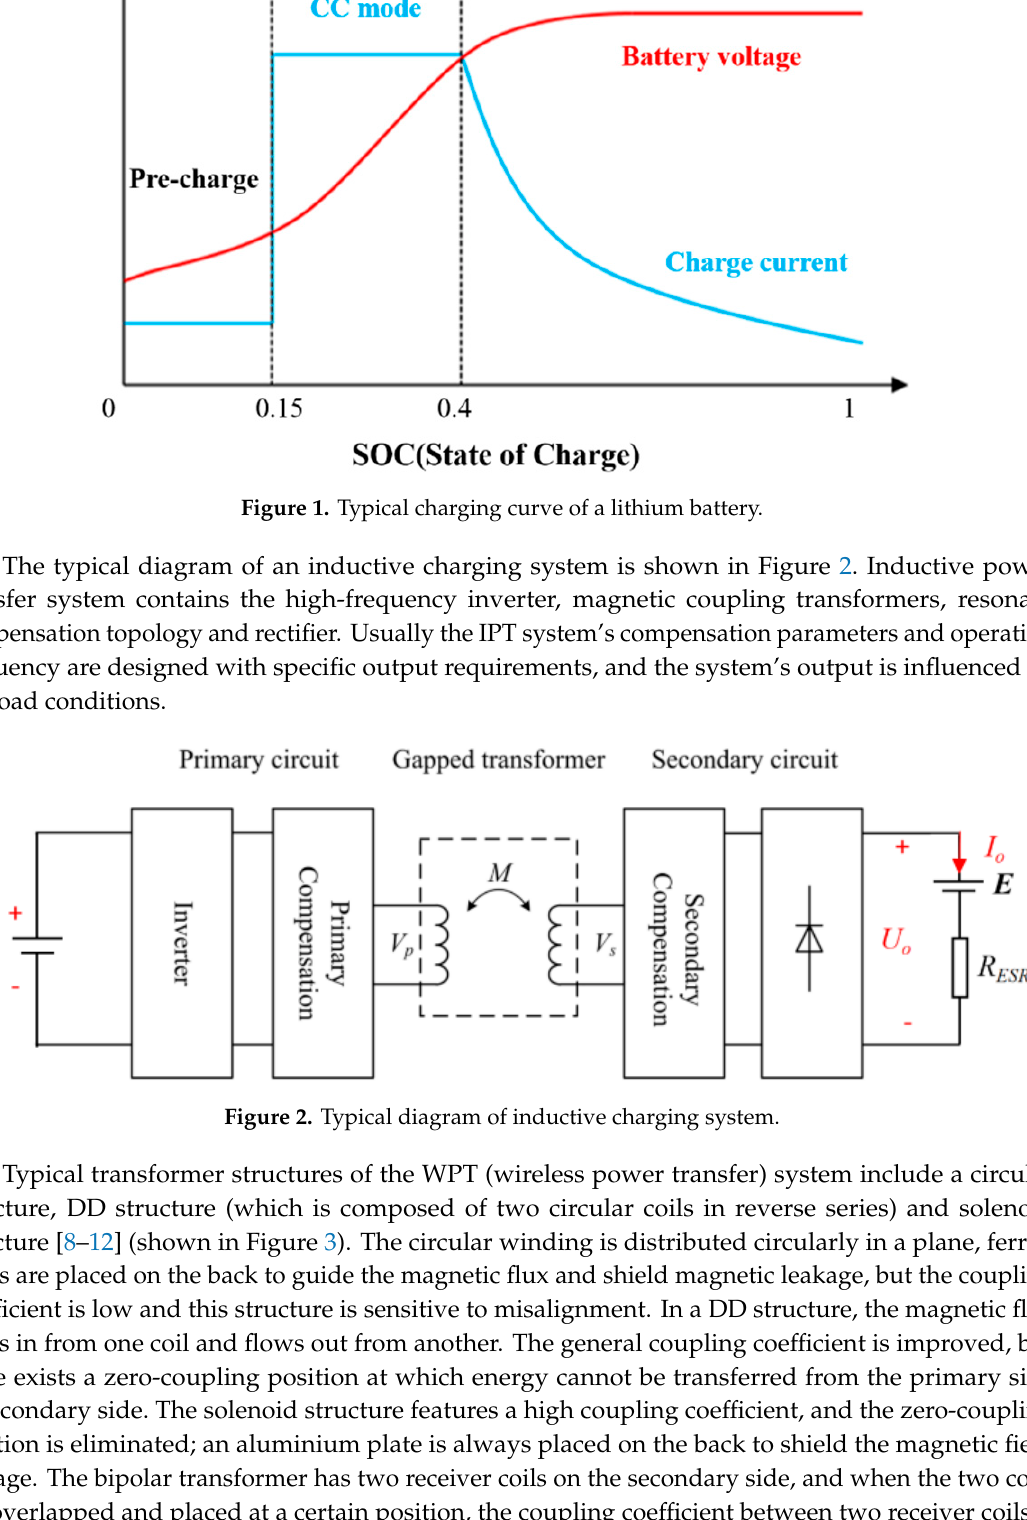
Figure 2. Typical diagram of inductive charging system.